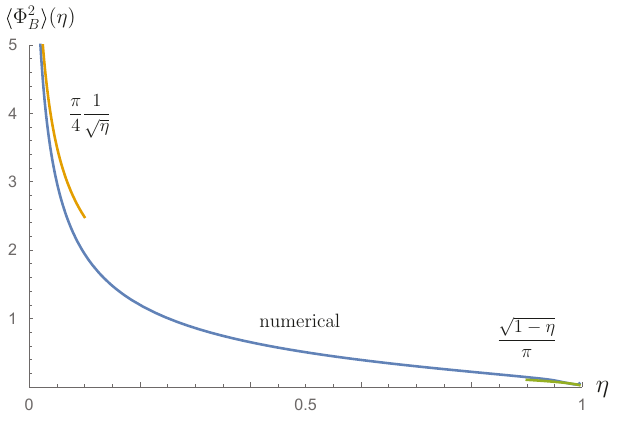
Figure 4. Optimal flux squared as a function of the ring cross